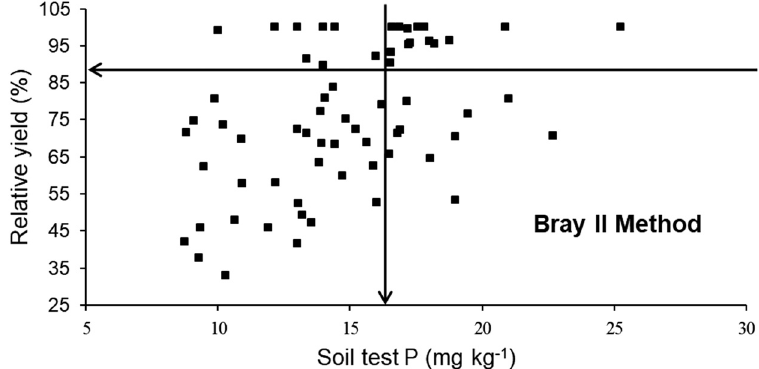
Figure 5: Scatter diagram showing the relationship between soil test P using the Bray II method and relative yield of malting barley, and the critical P